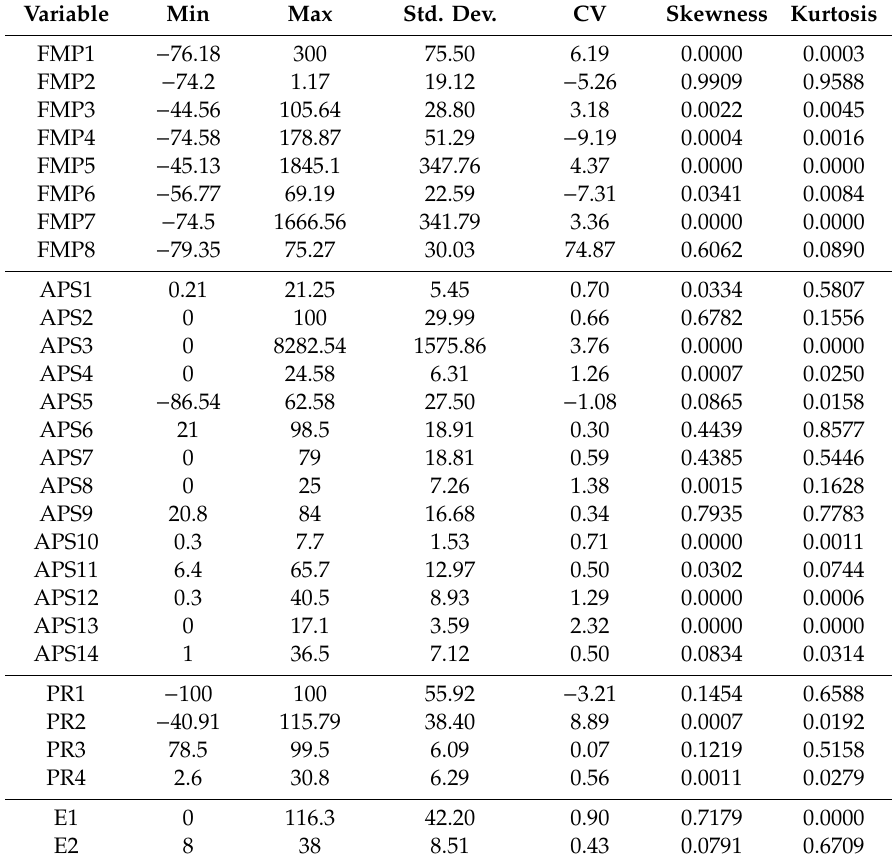
Table 2. Descriptive statistics of the country variables. Coe ffi cient of variation